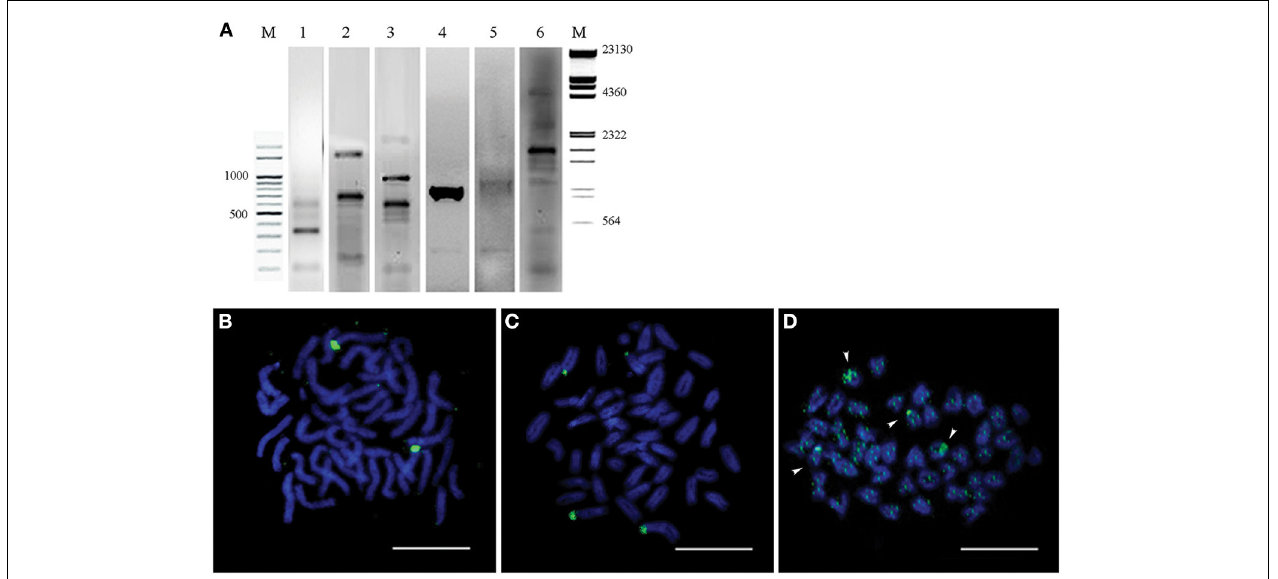
FIGURE 5 | Genomic hybridization and chromosomal location of two ribosomal DNAs (5S and 18s rDNA). (A) 18S rDNA (Lanes 1, 2) and 5S rDNA (Line 3) PCR products of the Lates calcarifer genome visualized on 2% agarose gel. Southern blot hybridization of the Asian seabass total DNA digested by restriction endonucleases HinfI and HindIII with the DIG-labeled 18S rDNA (Line 4) and 5S rDNA (Line 5) probes. 18S rDNA PCR product from